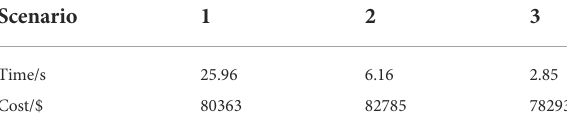
TABLE 2 Results comparison in Case